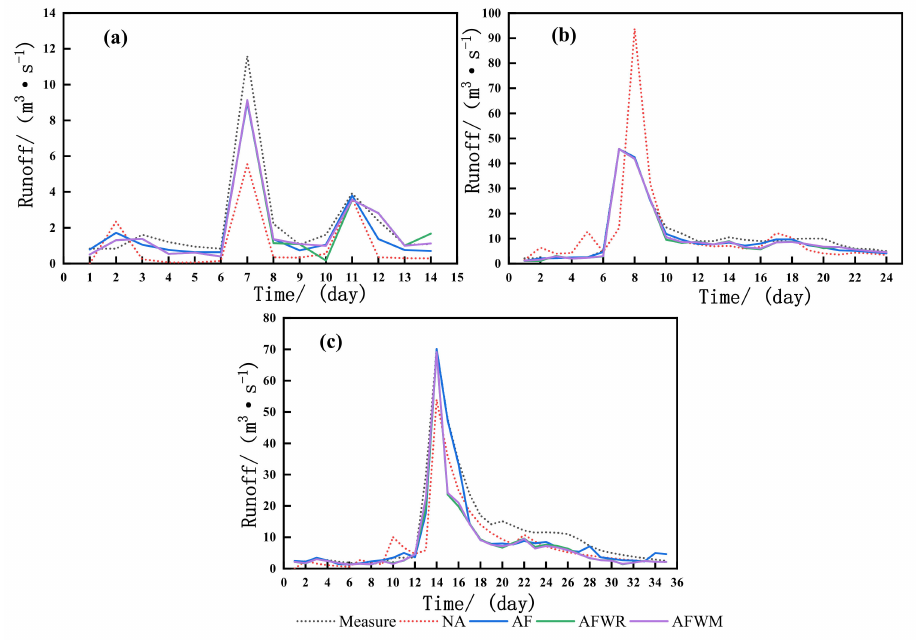
Figure 7. Variation in the flood runoff for medium floods for the measurement and four assimilation settings for the three stations: ( a ) Dage; ( b ) Gubeikou; ( c ) Xiahui. The average error values of the four assimilation settings are shown in Table 4. At the Dage Hydrological Station, the average AE and RE values of AF decreased by 72.7% and 37.3%, respectively, compared with NA. The effect of adding multi-source soil data was better than AF, and the AE and RE values of AFWR decreased by 6.6% and 1.6%, respectively, compared with AF. The AFWM was better than AFWR. Compared with AFWR, the AE and RE values of AFWM decreased by 3.5% and 0.7%, respectively. At the Gubeikou Hydrological Station, the average RE values of AF decreased by 4.3%, compared with NA, and the AE of AF was lower than the error value obtained after adding SM data. Compared with AEWR, the AE and RE values of AFWM were reduced by 10.5% and 1.6%, respectively. At the Xiahui Hydrological Station, the average AE and RE values of AF decreased by 116% and 8.8%, respectively, compared with NA. The error of AF was lower than that after adding SM data. Overall, the effect of AF was better than that of adding SM data. The average AE and RE values of AF decreased by 153% and 18.5%, respectively, compared with AFWM. The merged data were better than the satellite data, and the AE of AFWM was reduced by 7.3% compared with that of the